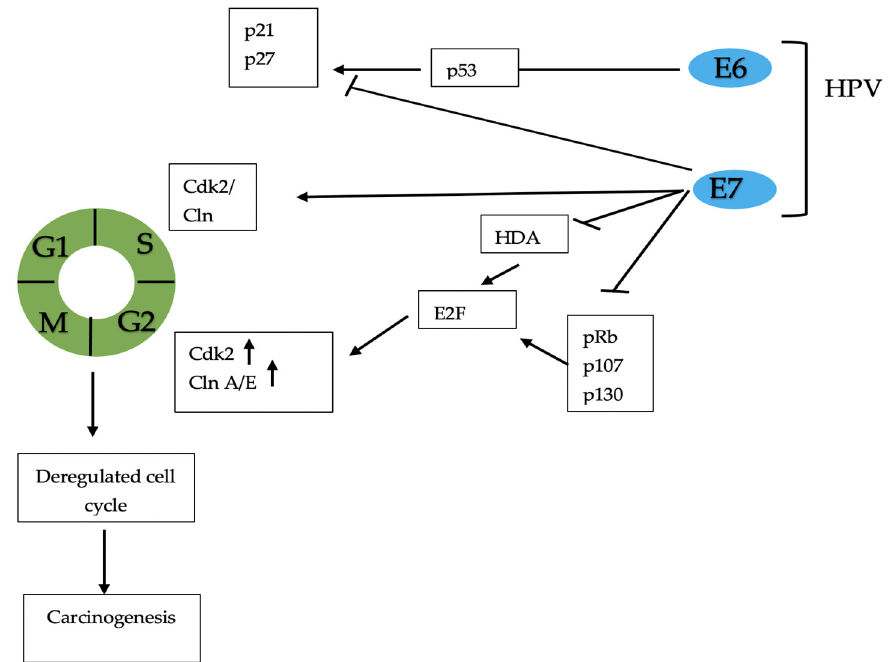
Figure 4. Molecular mechanisms of HPV-induced carcinogenesis. E6 and E7 bind and inactivate the p53 pathway, and pRb, p21, p27, p107, and p130 tumor suppressor gene products. This leads to cell cycle disregulation and carcinogenesis. HPV: human papillomavirus.